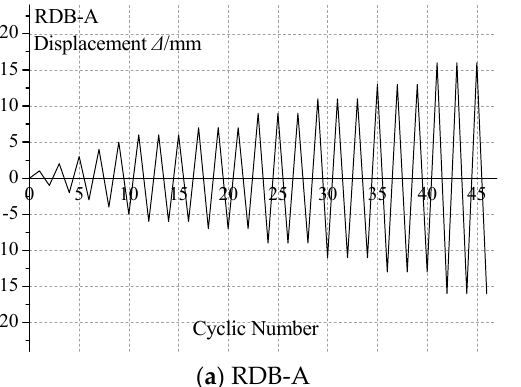
Figure 3. Arrangement of uniaxial strain gauges on the reinforcing bars.